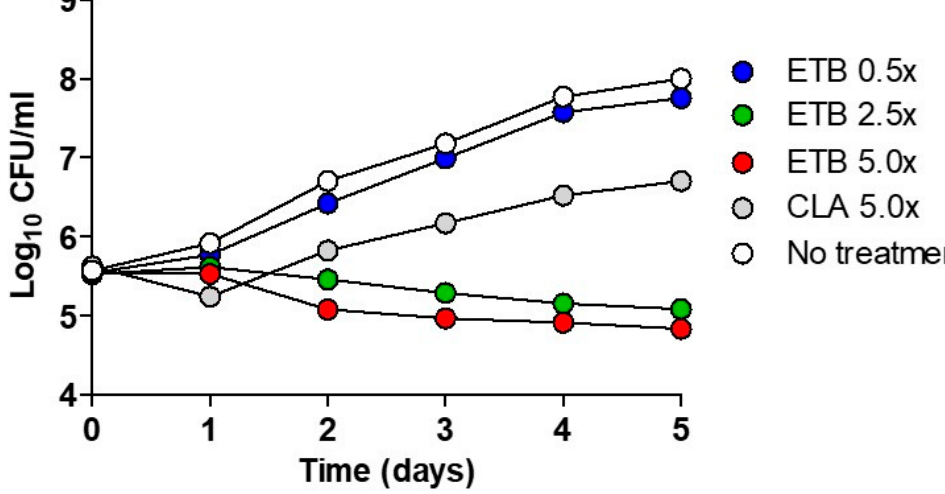
Figure 2. Time–kill curves of ETB against Mab . The bacteria were grown in a liquid culture (Middlebrook 7H9 medium) in the presence of the indicated concentrations of ETB and was plated on a 7H10 Middlebrook agar plate. Antibiotic concentrations are indicated by different symbols. Each point represents the mean of triplicate determinations.